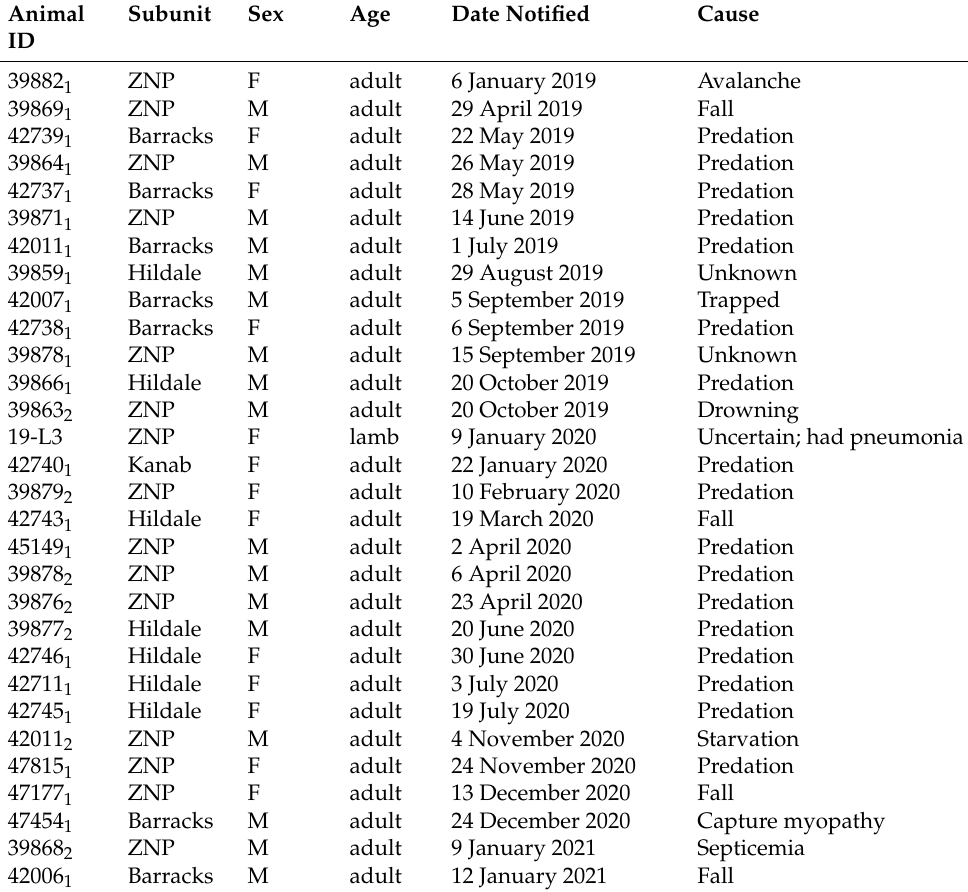
Table A1. Adult bighorn mortalities recorded in this study. Subscripts indicate collar deploy- ment numbers.